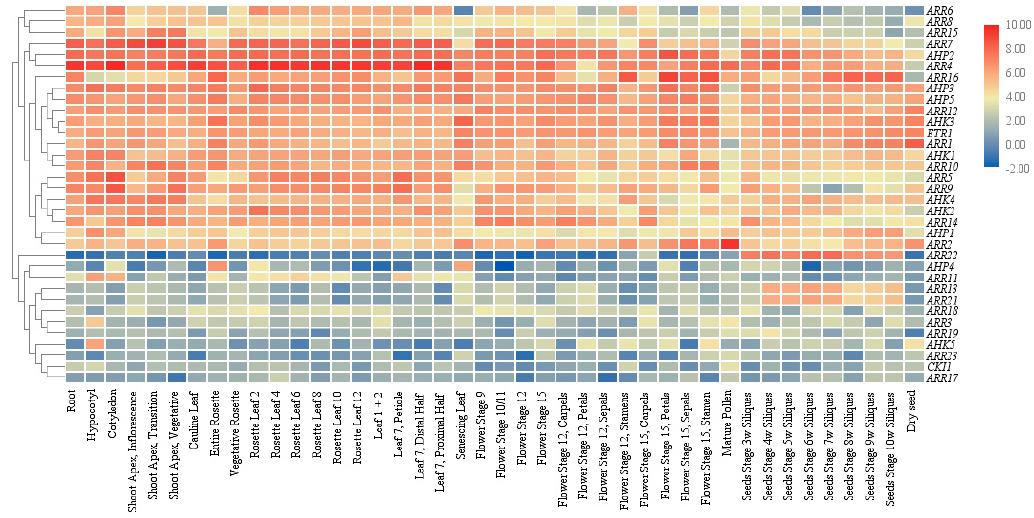
Figure 8. Hierarchical clustering and heat map representation for the TCS gene expression profiles in Arabidopsis . Gene expression data were obtained from the AtGenExpress Consortium ( Arabidopsis eFP Browser).